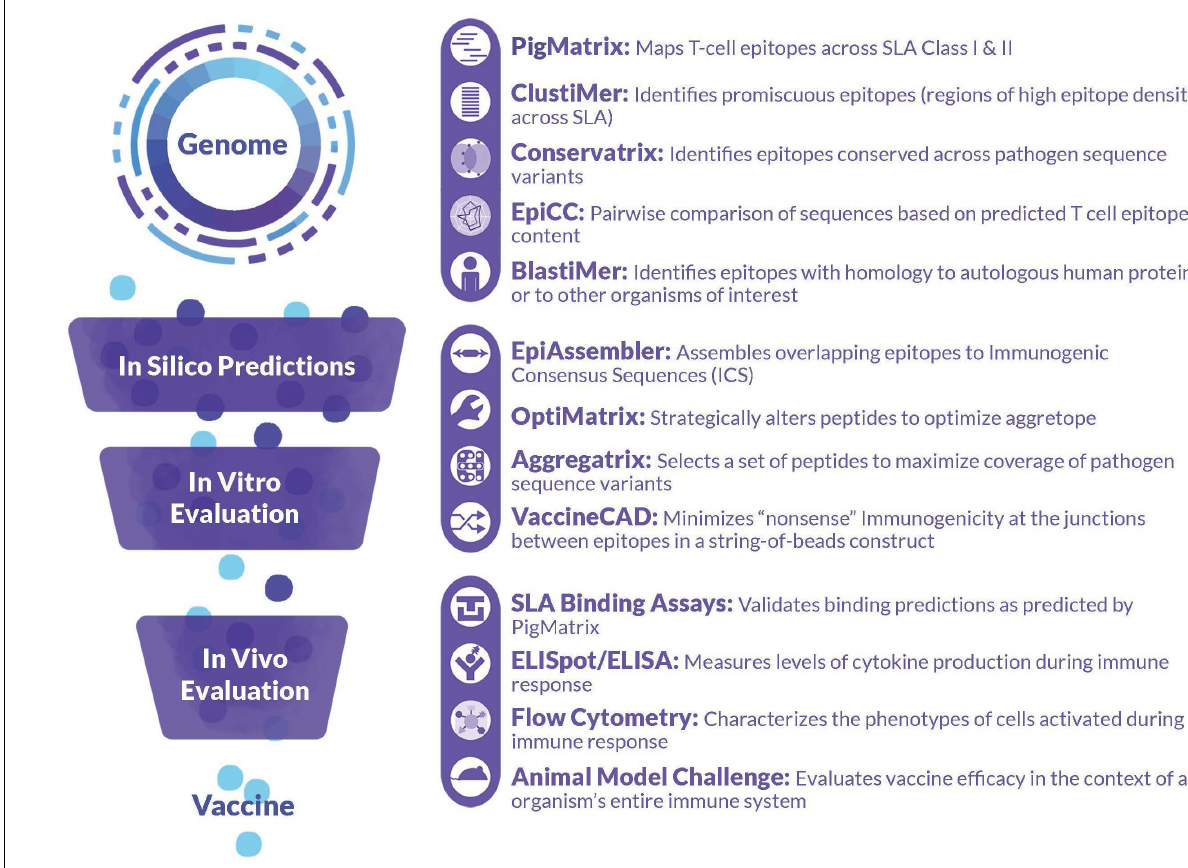
FIGURE 1 | Integration of PigMatrix and EpiCC into the iVAX Toolkit. The iVAX toolkit is a comprehensive set of tools for in silico analysis and computational vaccine design for humans. PigMatrix analyzes protein sequences for Class I and Class II SLA-restricted T cell epitopes. EpiCC defines the relatedness of sequences based on their T cell epitope content. The integration of PigMatrix and EpiCC into the existing iVAX toolkit allows them to be applied for the development of accelerated and improved swine vaccines.